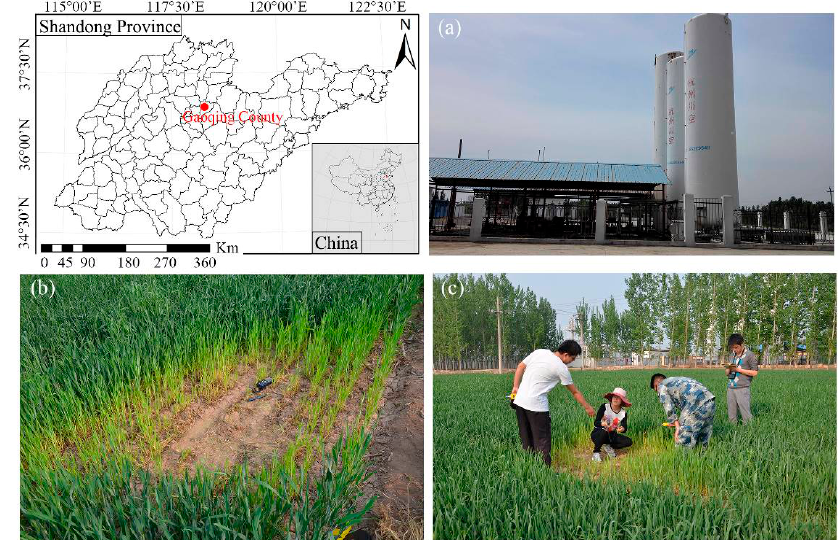
Figure 1. Location of the study area and research photos. ( a ) The High 89 CO 2 gas injection station; ff ected wheat growth; ( c ) soil sample ( b ) affected wheat growth; ( c ) soil sample collection. ( b ) a